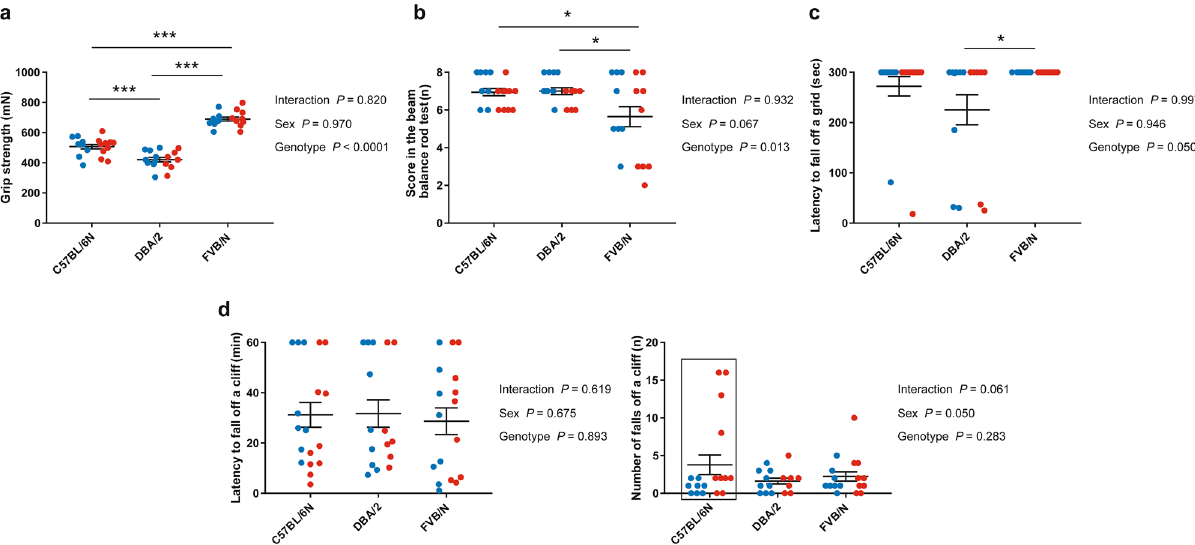
Figure 3. Coordination function in the P32–40 cohort of C57BL/6N, DBA/2, and FVB/N strains. ( a ) The grip strength test revealed FVB/N displaying the most powerful grip strength, DBA/2 showing the least grip strength with C57BL/6N being intermediate. ( b ) FVB/N displayed the lowest score in the beam balance rod test compared to C57BL/6N and DBA/2. ( c ) DBA/2 mice had the lowest latency to fall off a grid in the inverted screen test and reached significance compared to FVB/N mice. ( d ) In the cliff avoidance reaction test, no difference in the latency to fall off a cliff (left) or the number of falls (right) between the three investigated strains. Two-way ANOVA followed by Tukey post hoc test, * p ≤ 0.05, *** p ≤ 0.001. A black rectangle indicates a significant difference between sexes within a strain (see Supplementary Table 2). Blue and red dots refer to males and females, respectively. Error bars indicate the standard error of the mean